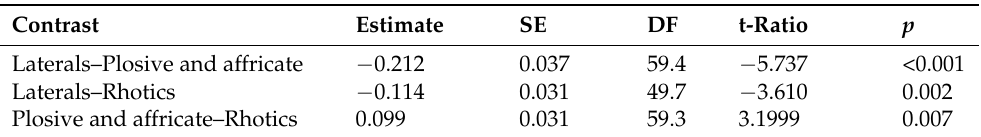
Table 7. Pairwise comparisons of reaction time by condition. ‘Estimate’ shows the difference in estimated marginal means on the log scale. Results are averaged over the levels of mono/bilingualism, dialect, and sex.